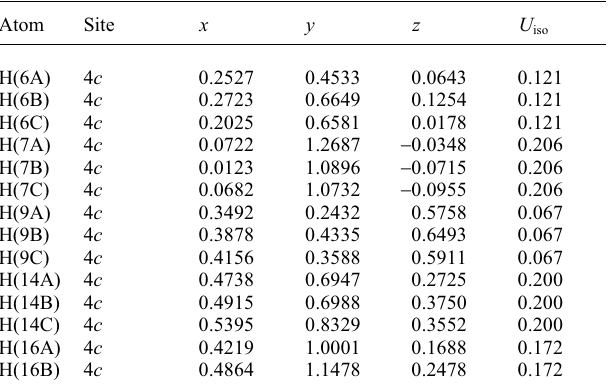
Table 2. Atomic coordinates and displacement parameters (in Å 2 )